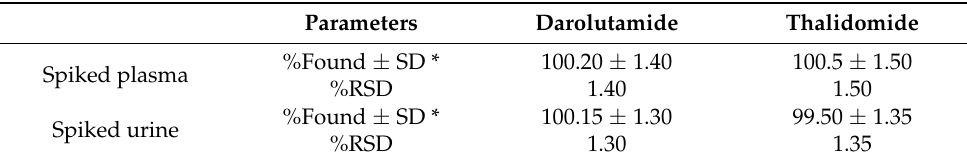
Table 3. Determination of darolutamide and thalidomide in spiked biological fluids by the proposed